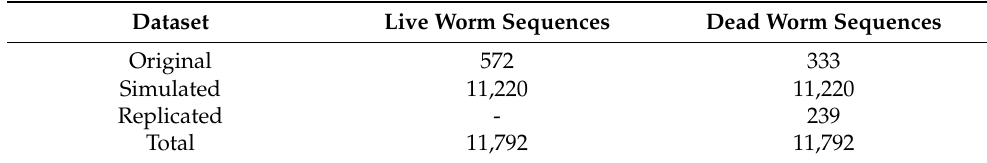
Table 7. Mixed dataset.